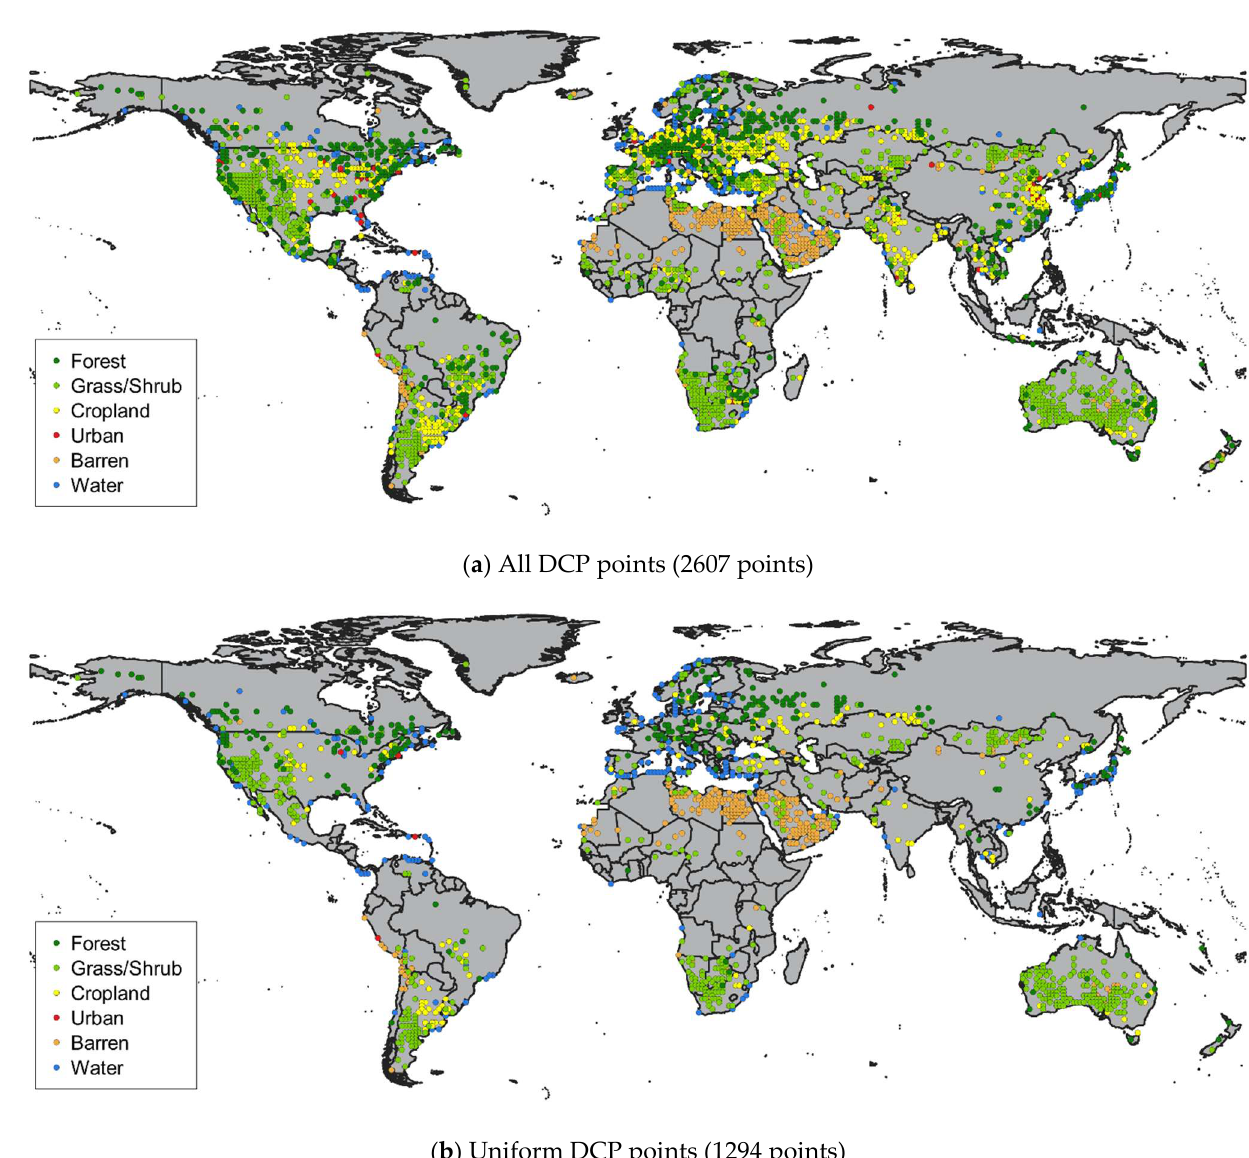
Figure 5. Distribution of ( a ) all DCP points and ( b ) DCP points with guaranteed uniformity at the 990 m scale.